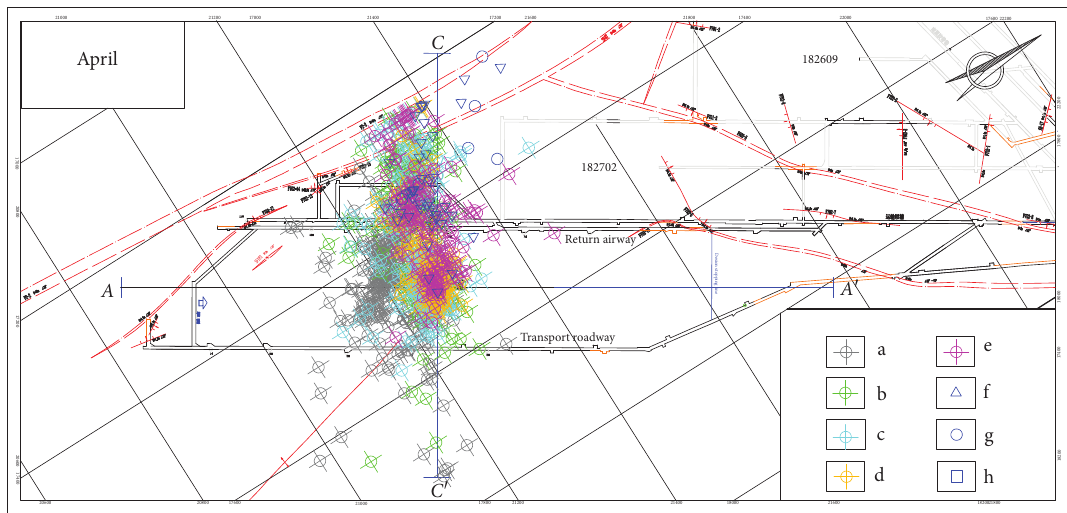
Figure 11: Distribution plan of microseismic events in April. a: shallow of 2# coal; b: floor of 2# coal-floor of Yeqing limestone; c: floor of Yeqing limestone-floor of Fuqing limestone; d: floor of Fuqing limestone-floor of Daqing limestone; e: floor of Danqing limestone-roof of Ordovician limestone; f: Ordovician limestone (0–50m); g: Ordovician limestone (51–150m); h: Ordovician limestone (150m-deep part).